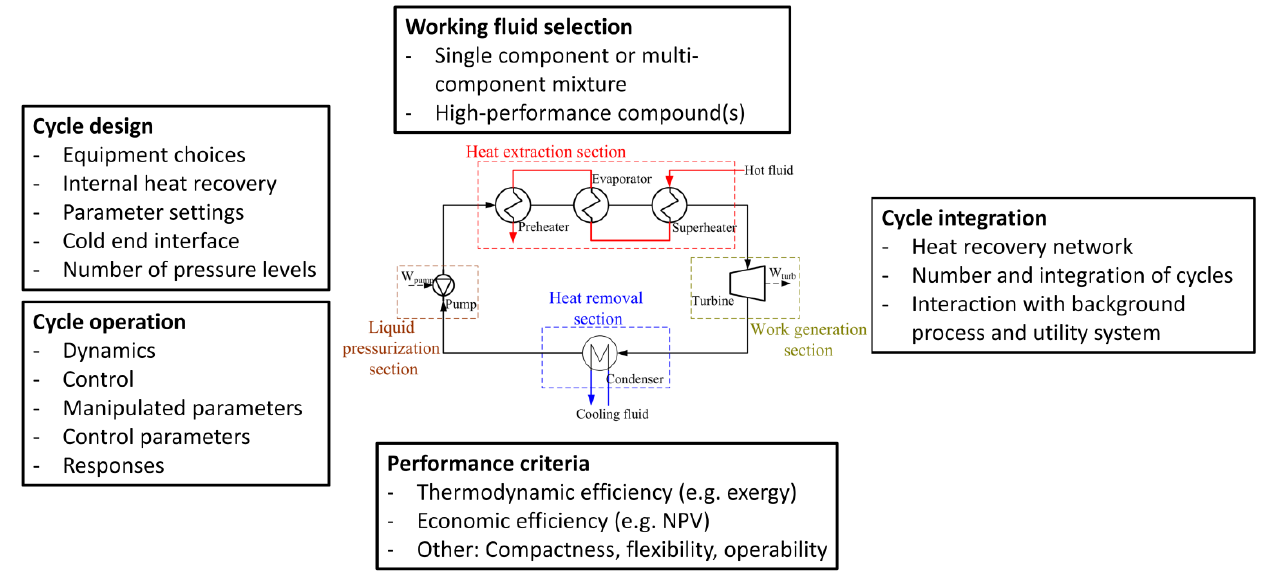
Figure 1. ORC design decisions and